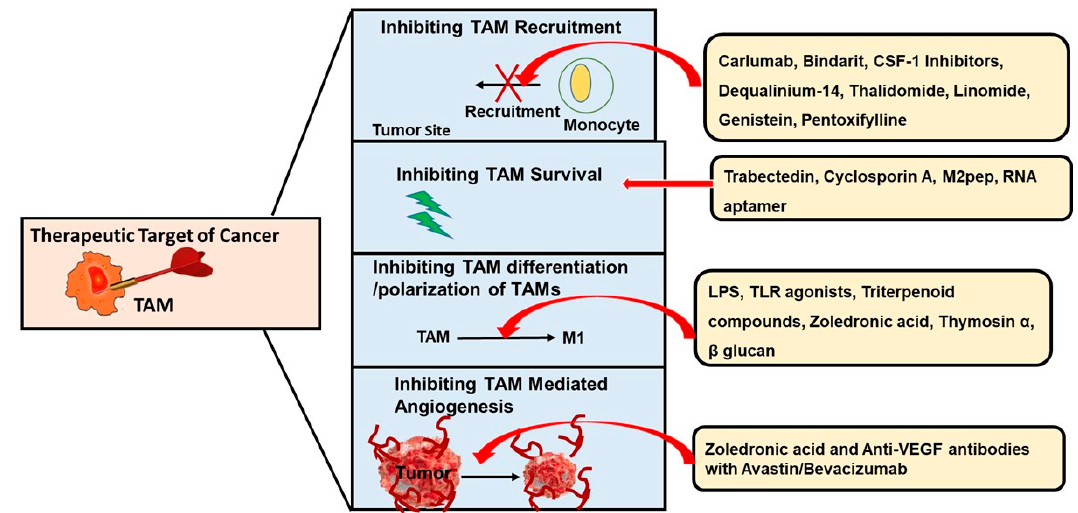
Figure 3. TAMs Targeted Anticancer Therapy. The variable role of TAMs in the TME makes them a potential target to fight against cancer progression. The first approach can be to inhibit TAM recruitment to the tumor site. Drugs such as Carlumab, Bindarit, Thalidomide, etc., can inhibit monocyte recruitment to the tumor site so that they cannot convert into TAMs and cause tumor growth. Trabectedin and Cyclosporin A inhibit tumor growth by targeting or killing TAMs or downregulating TAM survival through different mechanisms. Another approach to prevent TAM-mediated tumor progression is to reduce its differentiation and polarization. LPS and TLR agonists can reverse macrophage polarization by converting them back to M1 antitumor phenotype, while Triterpenoid compounds have been found to inhibit the initial polarization of M1 macrophages to M2 phenotype. Lastly, inhibition of angiogenesis can be a potential approach to treat tumor progression. The use of anti-VEGF-antibody in combination with Avastin, Bevacizumab, or other neutralizing antibodies can inhibit macrophage infiltration as well as angiogenesis.